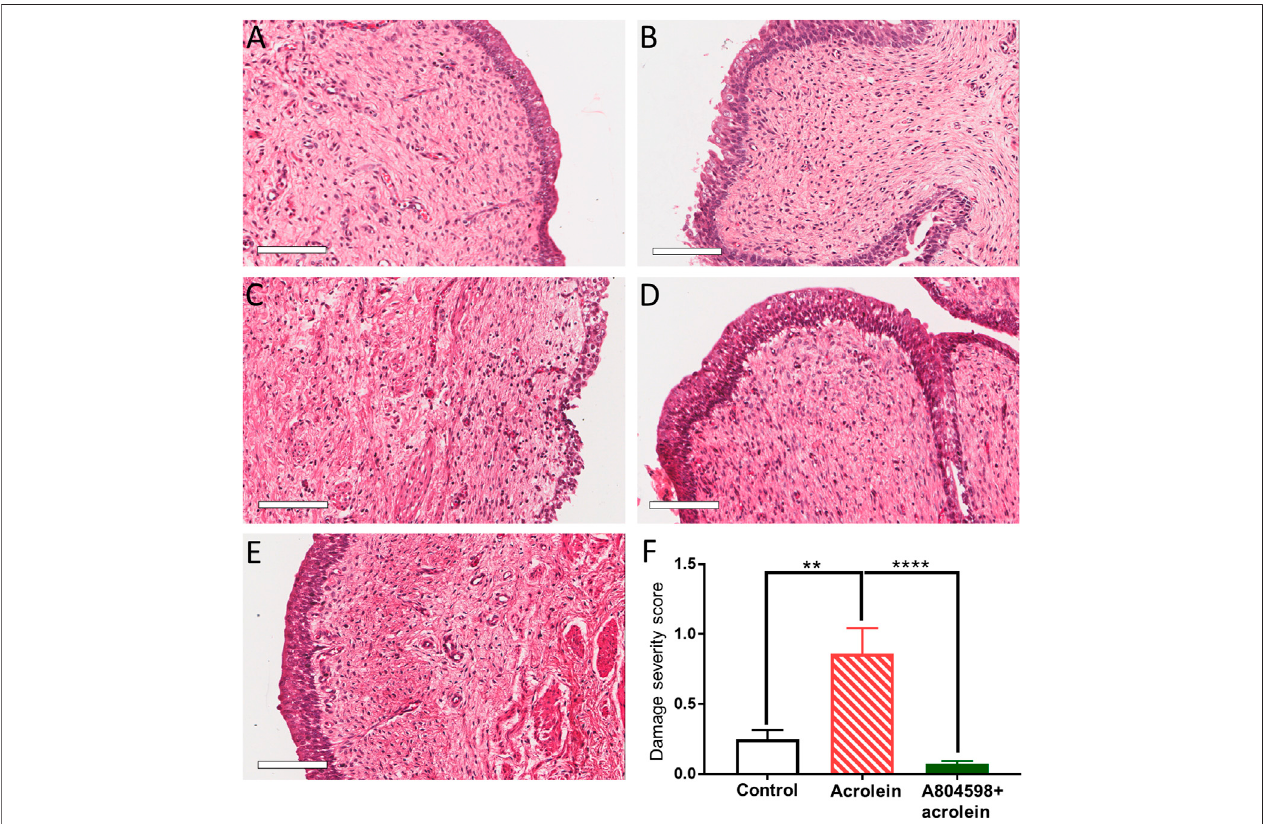
FIGURE 1 | Histological comparison of the porcine bladder mucosal sections of acrolein-induced ex-vivo in fl ammatory model. (A) Fresh control: hematoxylin and eosin (H&E) staining of the porcine bladder fi xed with Zamboni ’ s solution immediately following dissection. (B) Perfusion control: H&E staining of the porcine bladder which has undergone 4 h perfusion with the RPMI 1640 media before fi xation in Zamboni ’ s solution. (C) Acrolein treated: H&E staining of the porcine bladder perfused with acrolein (0.05%) for 4 h. (D) A804598 only: H&E staining of the porcine bladder pre-treated with A804598 (10 μ M) for 1 h prior to 4 h perfusion with RPMI media. (E) A804598 + acrolein: H&E staining of the porcine bladder pre-treated with the P2X7 receptor antagonist A804598 (10 μ M) for 1 h prior to 4 h perfusion with acrolein (0.05%). (F) Quantitative measurement of the severity of bladder mucosal damage based on the criteria described in Table 1 . The data are shown as mean ± SEM from n (cid:2) 5 bladders for each group (** p < 0.01; **** p < 0.0001 compared to the acrolein treated group, one-way ANOVA followed by Bonferroni test). Scale bars (cid:2) 100 μ